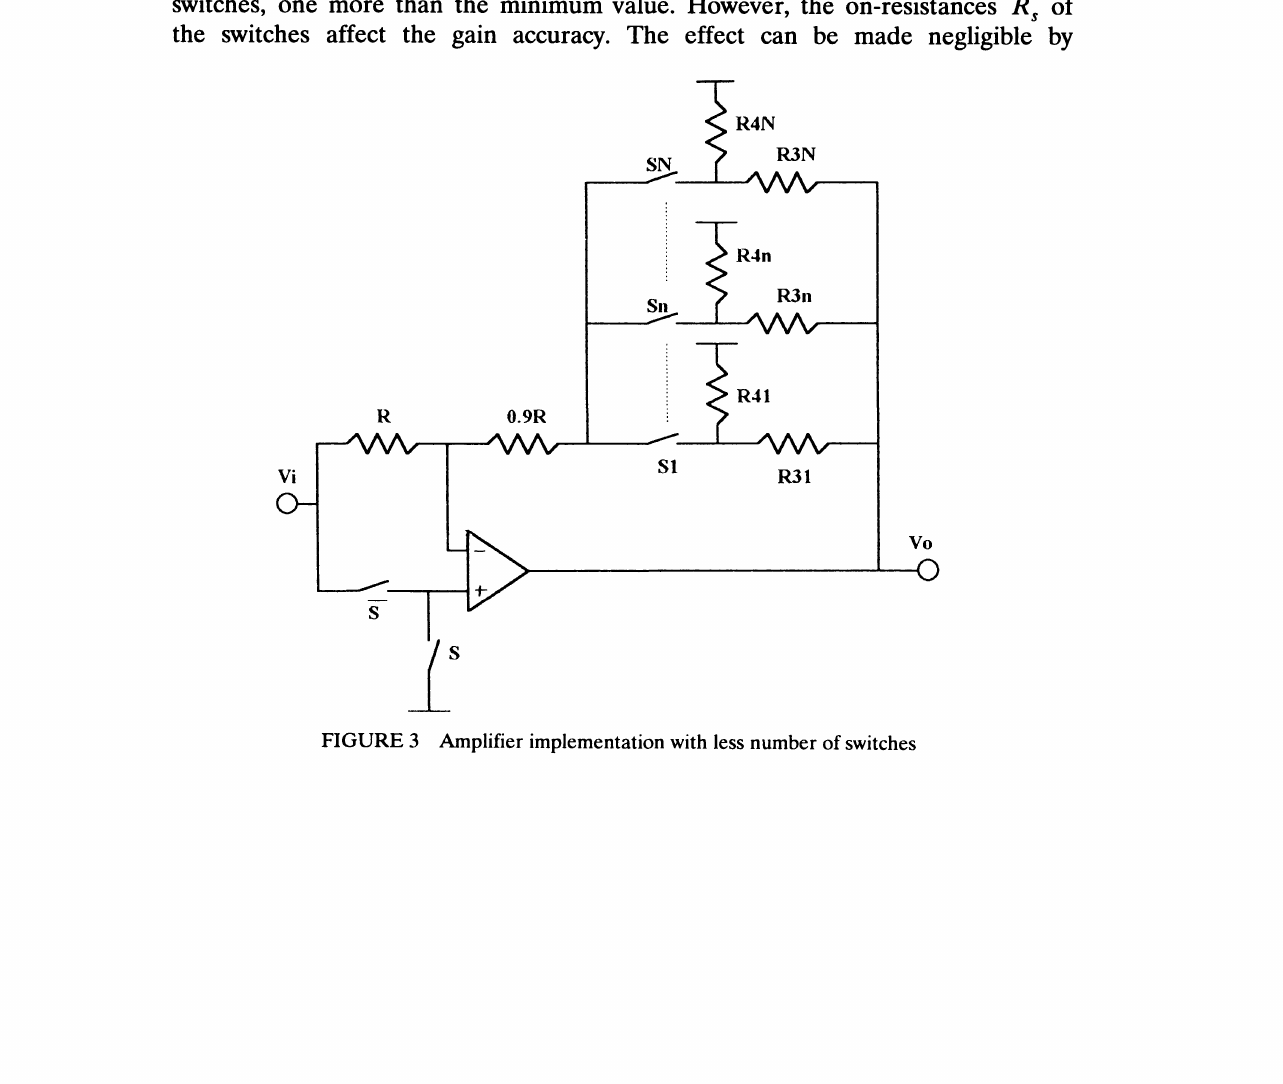
FIGURE 3 Amplifier implementation with less number of